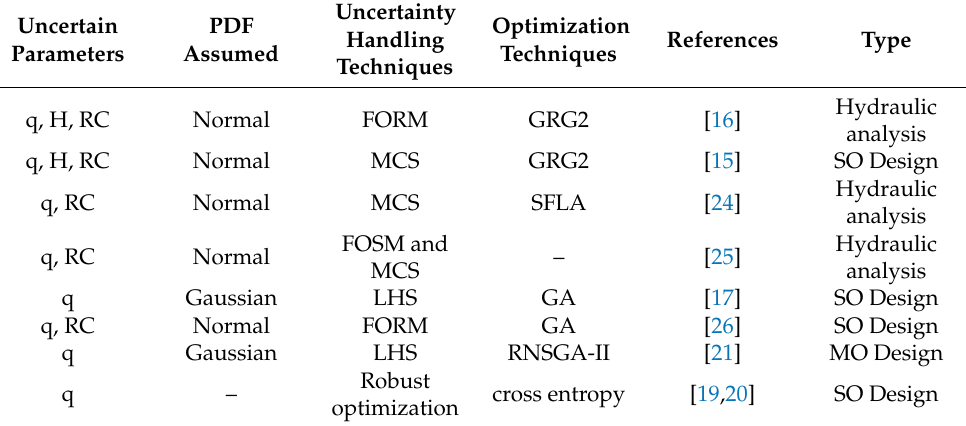
Table 1. List of few works in the area so WDS design and analysis under